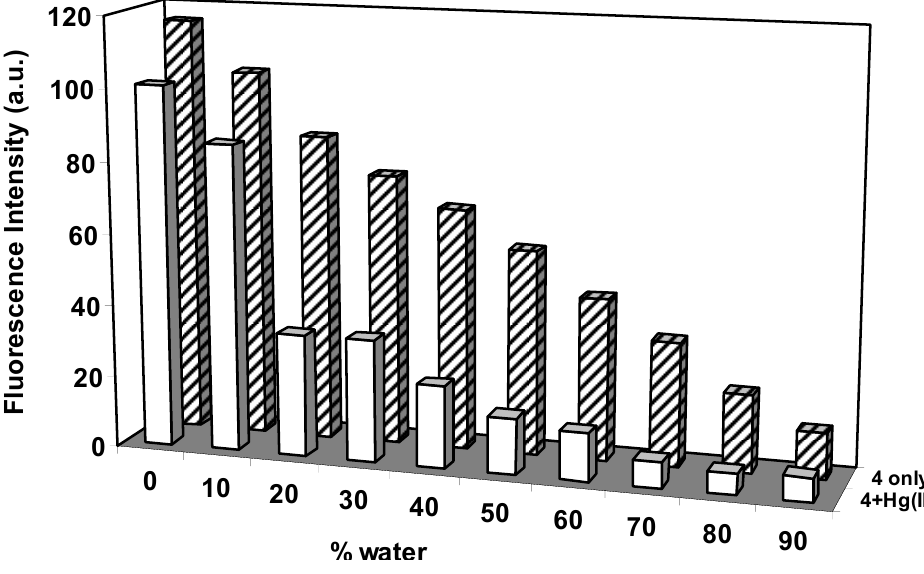
Figure 3. Fluorescence intensity changes of 4 (0.5 μ M) as a function of water content in aqueous acetonitrile solution at 515 nm in the absence and presence of Hg 2 + (20 equiv), λ 338 nm.